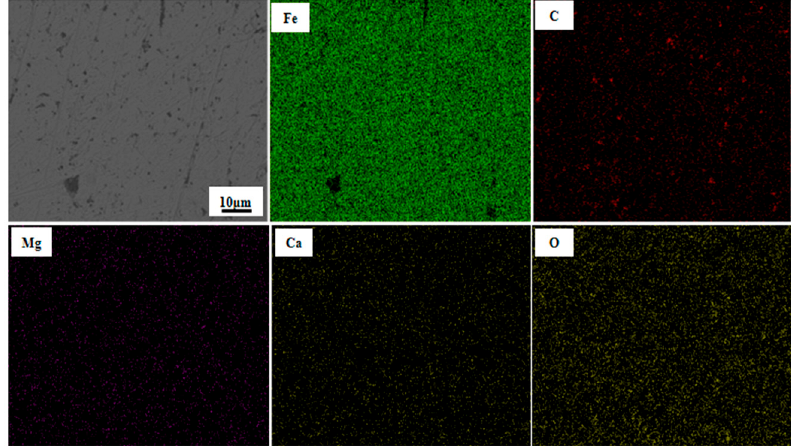
Figure 19. Effect of carbon content on theoretical melting point ( a : low MgO; b : high MgO).